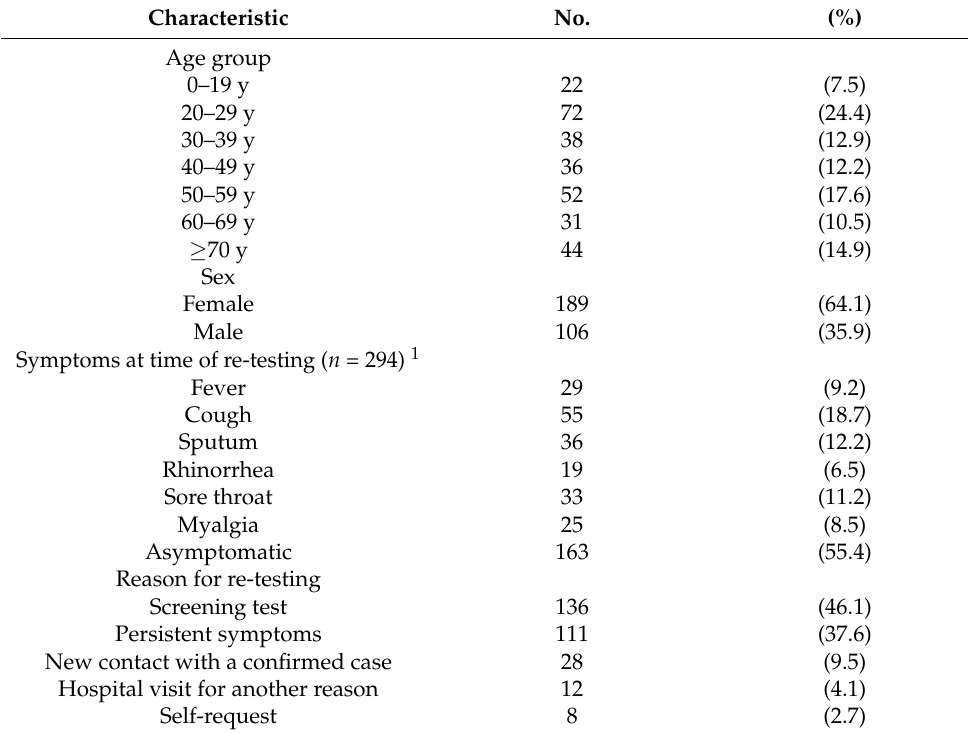
Table 1. Clinical characteristics of individuals with confirmed re SARS-CoV-2 positivity on PCR